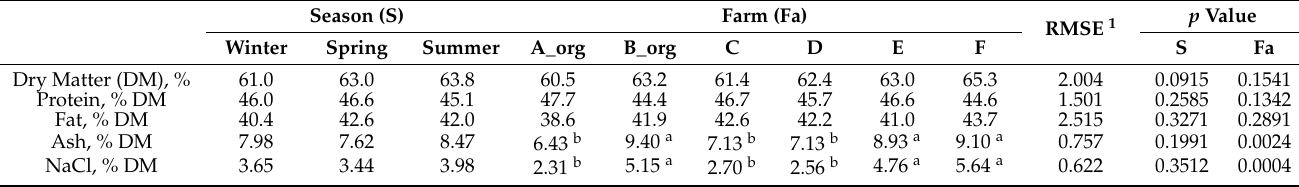
Table 3. Effect of production season on Caciocavallo cheese